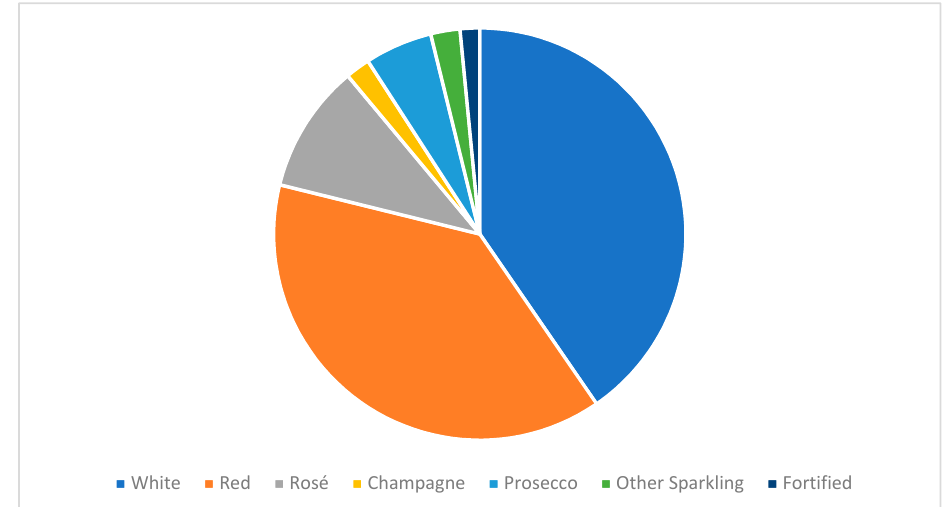
Figure 3. UK wine consumption by category. Source: Adapted from data supplied by Wine and Spirit Trade Association Market Overview, 2017.